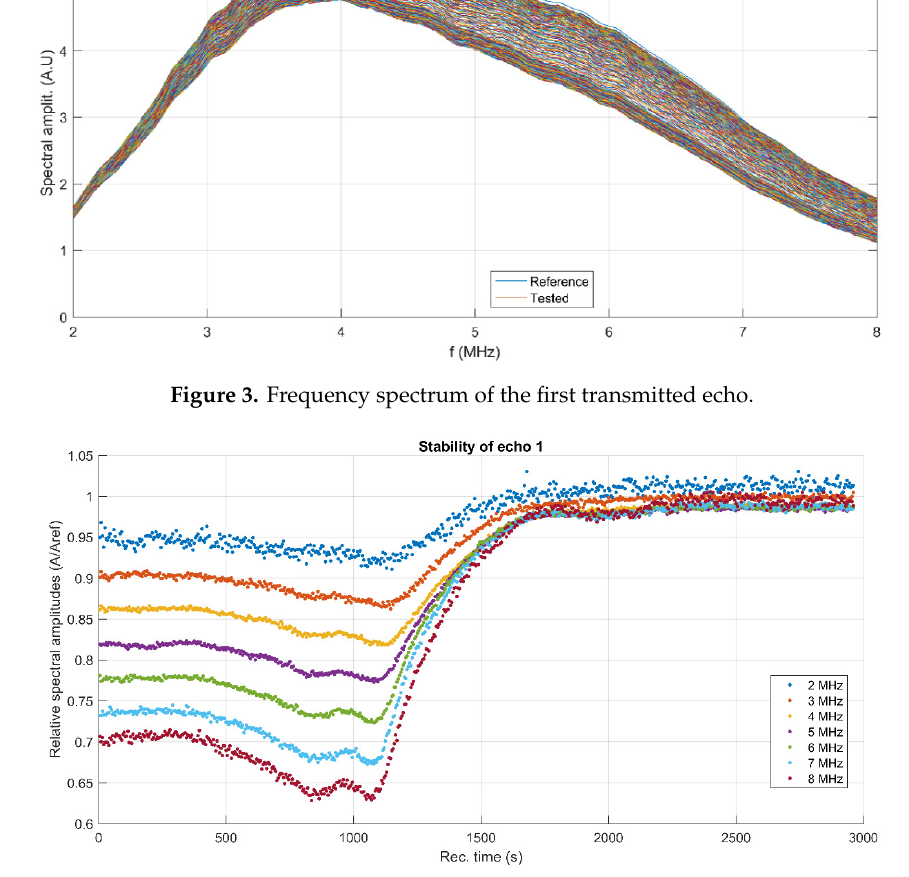
Figure 4. Spectral amplitudes of relative variation vs. time for the first echo.